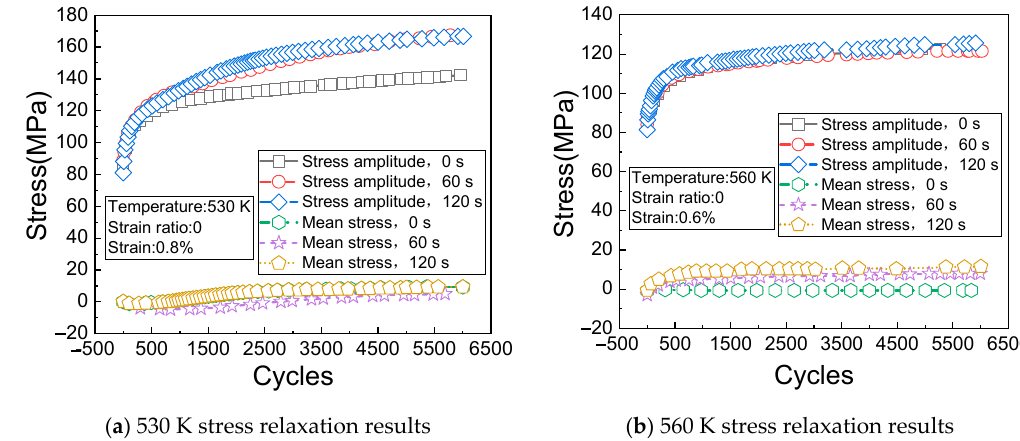
Figure 8. Stress relaxation results at 530 K and 560 K. ( a ) 530 K stress relaxation results; ( b ) 560 K stress relaxation results.